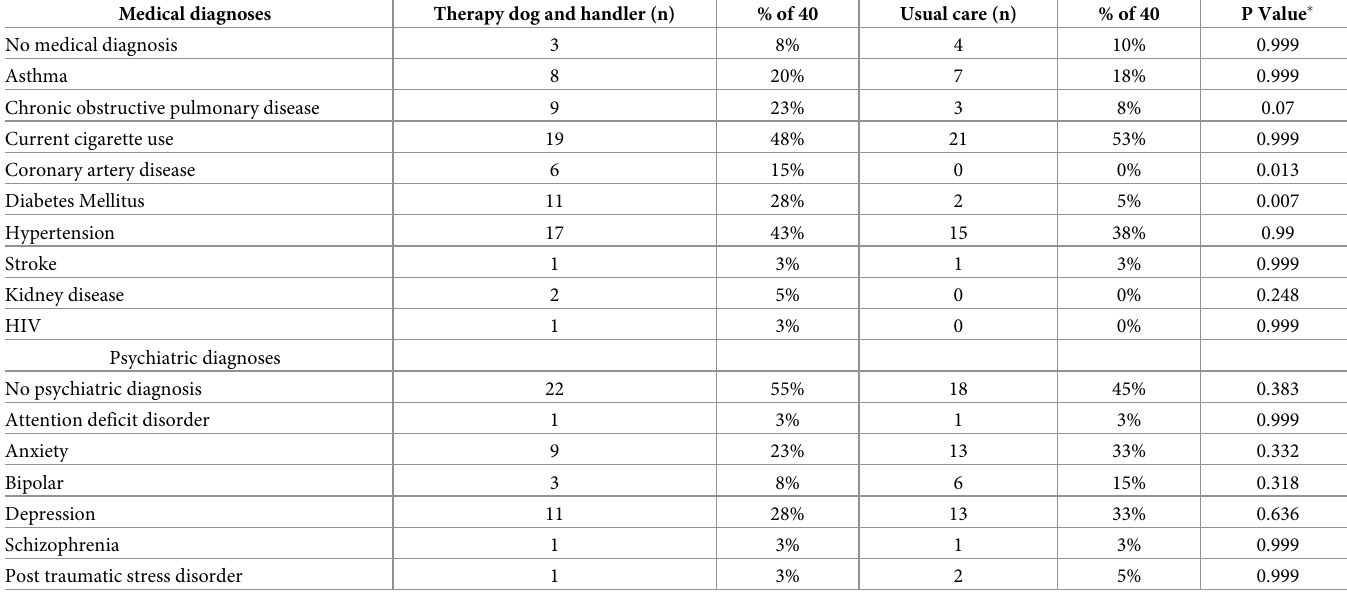
Table 2. Past medical and psychiatric diagnoses.